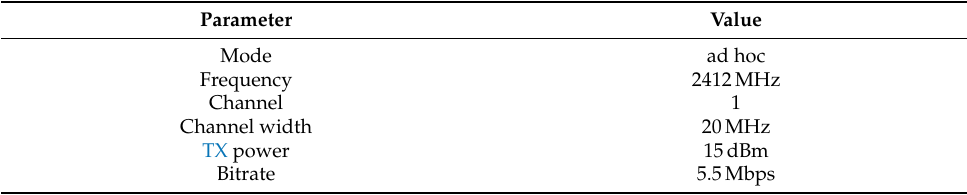
Table 4. Default parameters used in application-network integration evaluation.